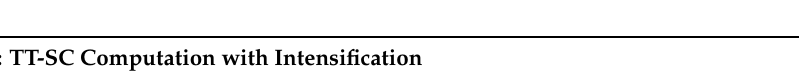
Algorithm 3: TT-SC Computation with